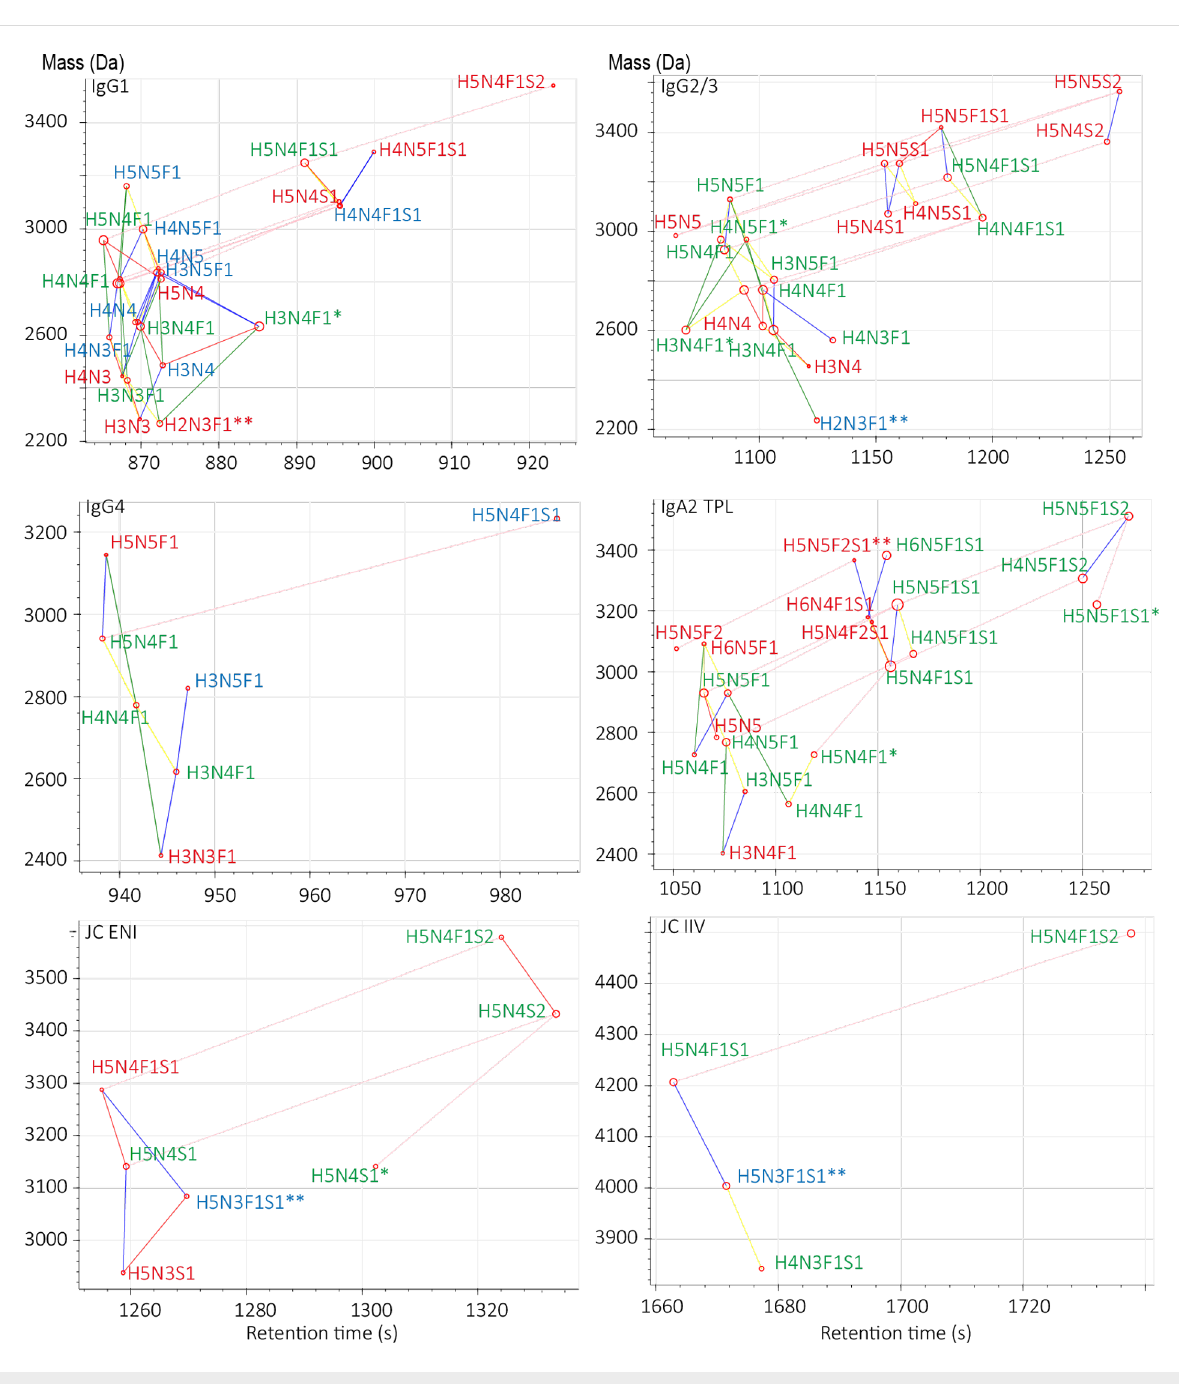
Figure 3: Representative GlycopeptideGraphMS output for peptides of interest. Assigned compositions were identified using MS/MS data via Byonic (green) or manual assignment (blue) or by MS1 only (red, GlycopeptideGraphMS with additional accurate-mass and isotopic pattern check of the raw data). The assignment of the compositions is based on information from all replicates. Lines between compositions indicate the mass difference for Hex (yellow), HexNAc (blue), HexHexNAc (green), Fuc (red), and NeuAc (purple). * Indicates potential deconvolution errors and ** indicates data not included in the Byonic search